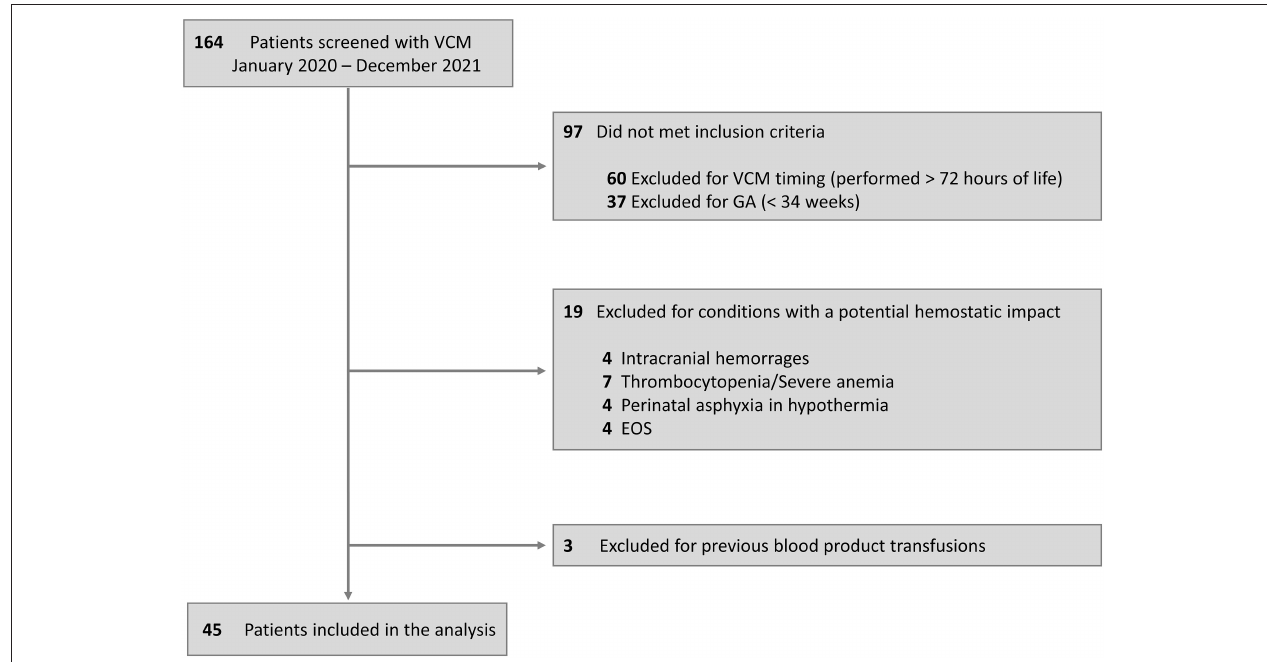
FIGURE 2 | Flow diagram. VCM, viscoelastic coagulation monitor; GA, gestational age; EOS, early-onset sepsis.